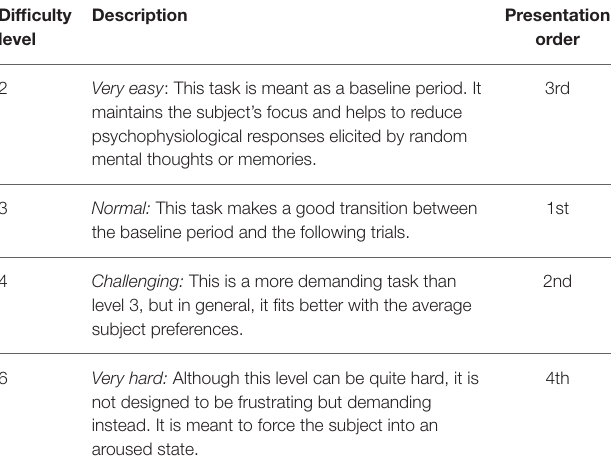
TABLE 1 | The four levels of task difficulty in the open-loop experiment ( n =